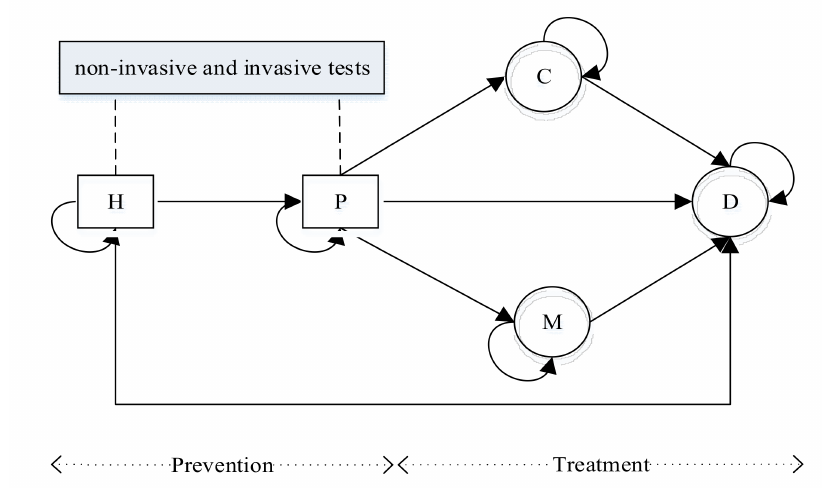
Figure 1. State transition